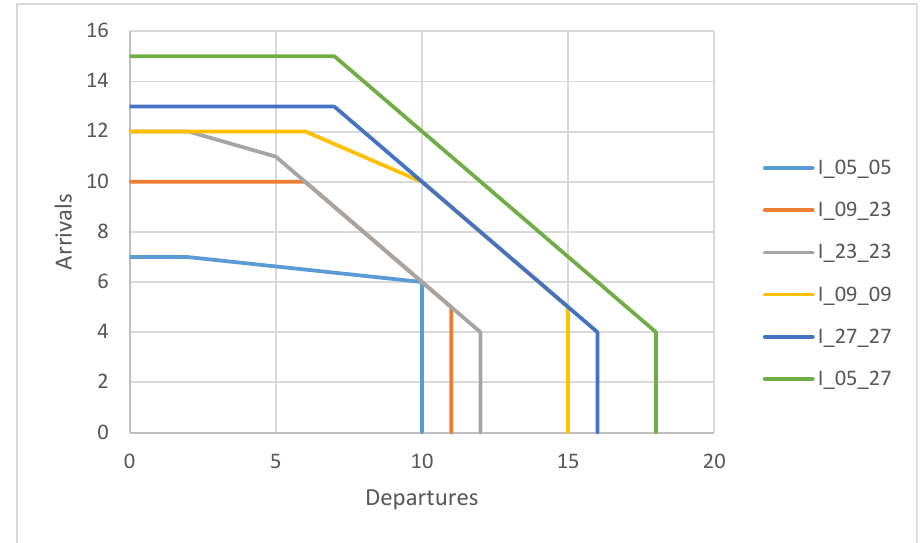
Figure 11. The Pareto frontier of the examined scenarios .